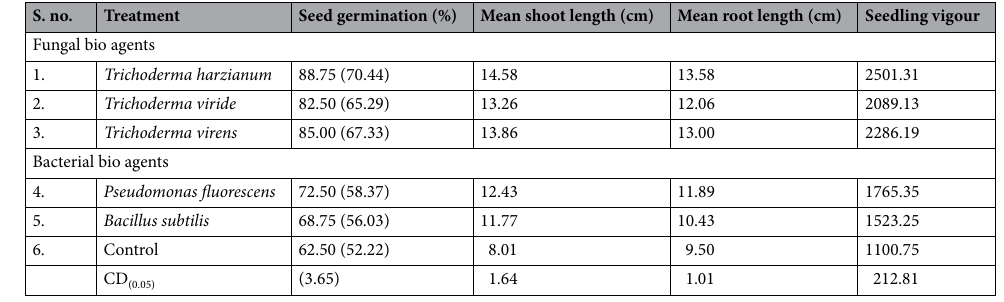
Table 2. Effect of bio control agents on shoot length, root length, germination percentage and seedling vigour of cucumber var. Solan Srijan. Figures in the parentheses are arc sine transformed. Statistical analysis was done on opstat